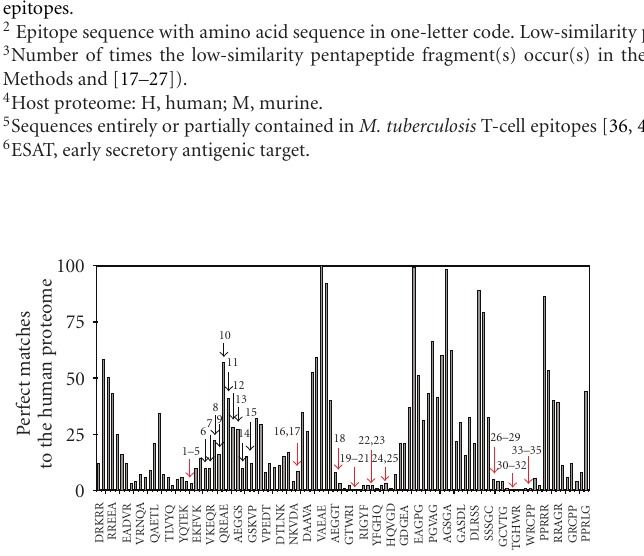
Figure 1: Similarity profile of the mycobacterial DNAK carboxy- terminus domain versus the human proteome at the pentapeptide level. The columns indicate the number of DNAK pentapeptide occurrences in the human proteome. DNAK corresponds to hsp70 protein, UniProt accession: P0A5B9; length: 609 aa. The numbered arrows indicate the location of mycobacterial peptide sequences immunoassayed with human sera